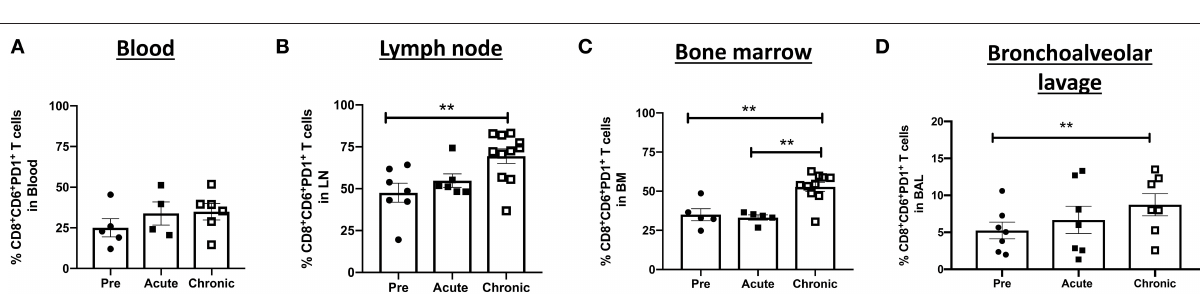
Frontiers in Immunology |